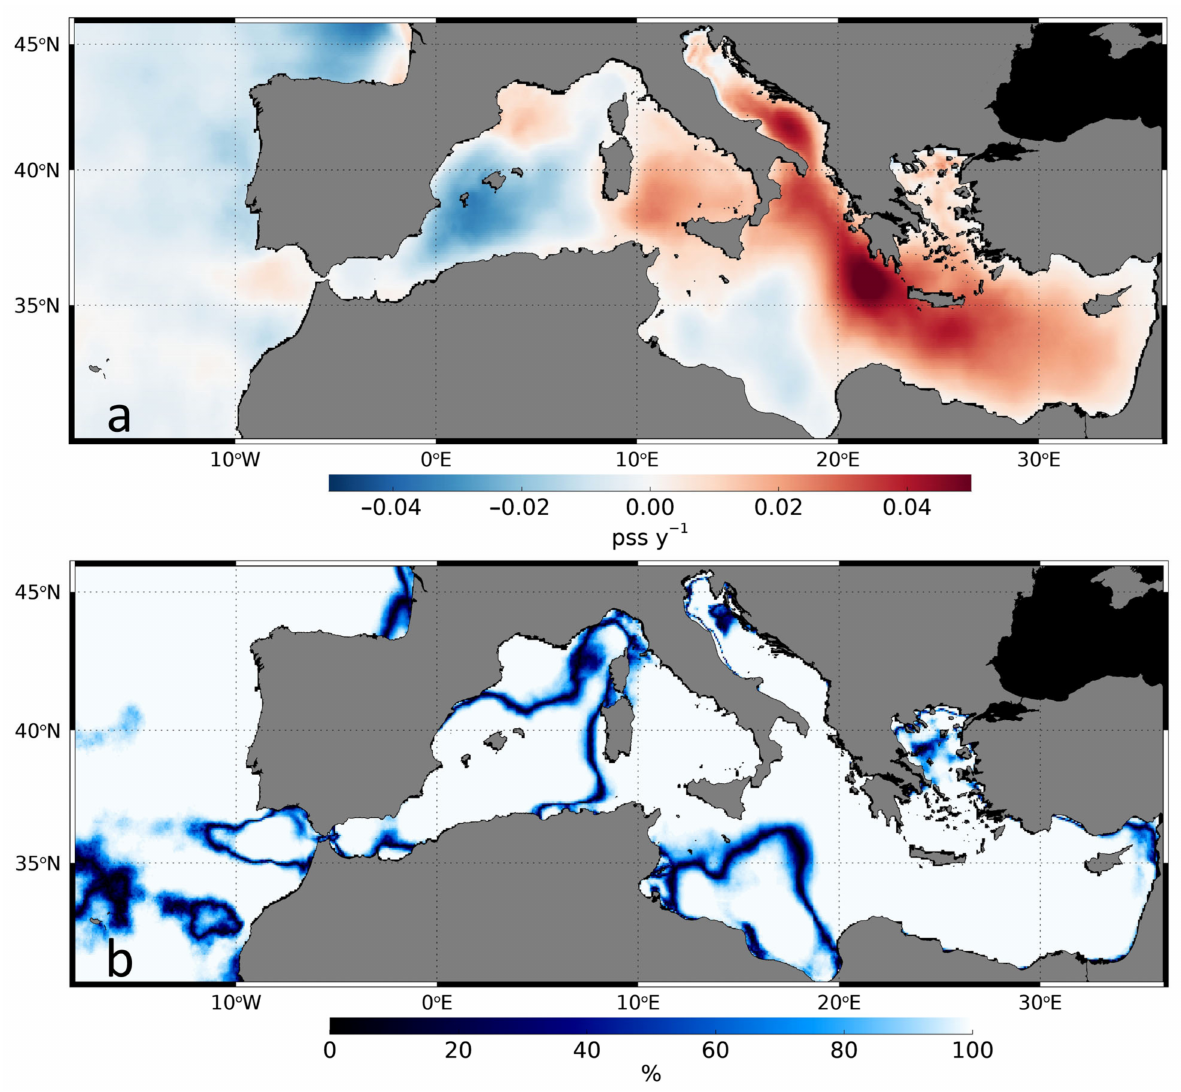
Figure 10. SSS trend map (pss year − 1 ) ( a ) and its significance level (%) ( b ), for the 2010–2020